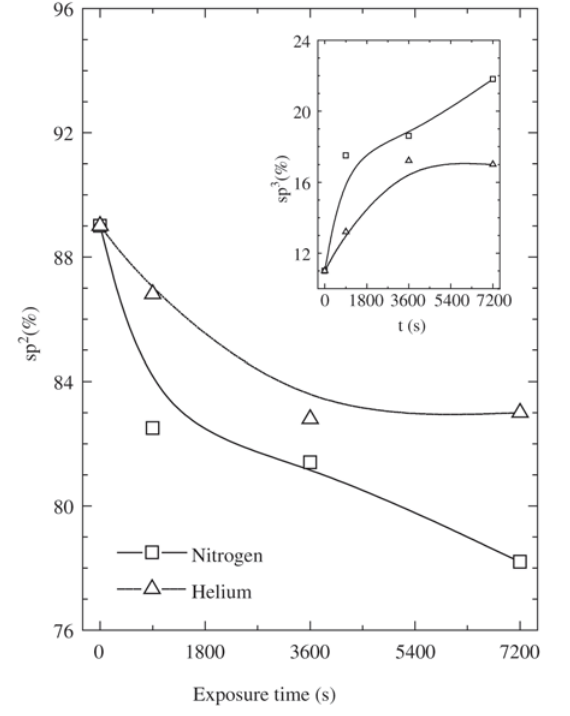
Figure 3. Proportion of sp 2 C bonds in the films as a function of the treatment time. The insert plot shows the proportion of sp 3 co-